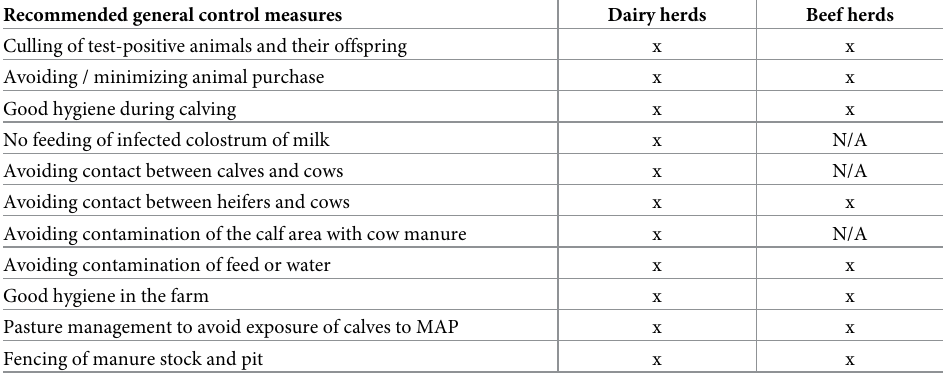
Recommended general control measures Dairy herds Beef